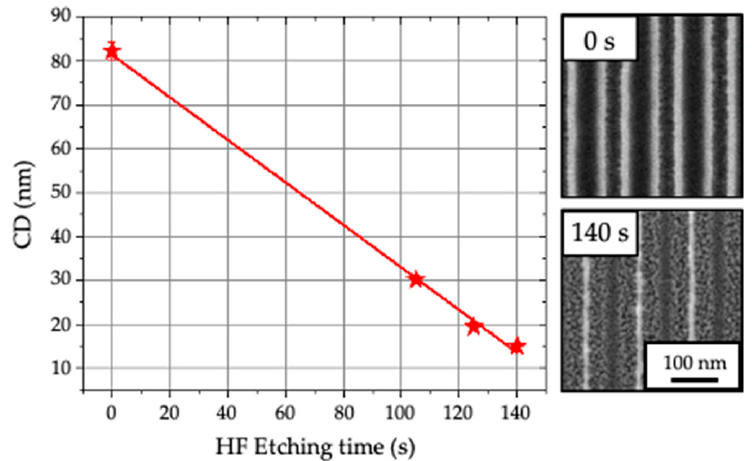
Figure 2. Lateral etching rate of TEOS lines with HF 1% and representative CD-SEM plan-view images of TEOS lines before etching (0 s) and after 140 s.